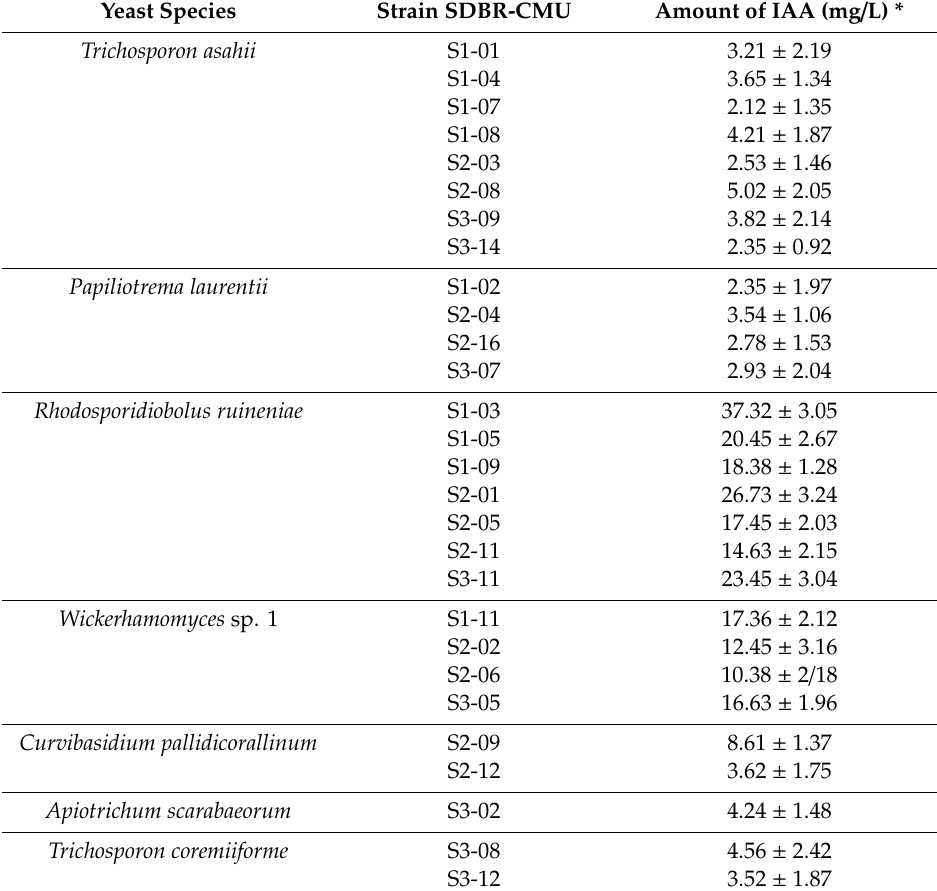
Table 3. Production of indole-3-acetic acid by yeast strains in this study. Yeast